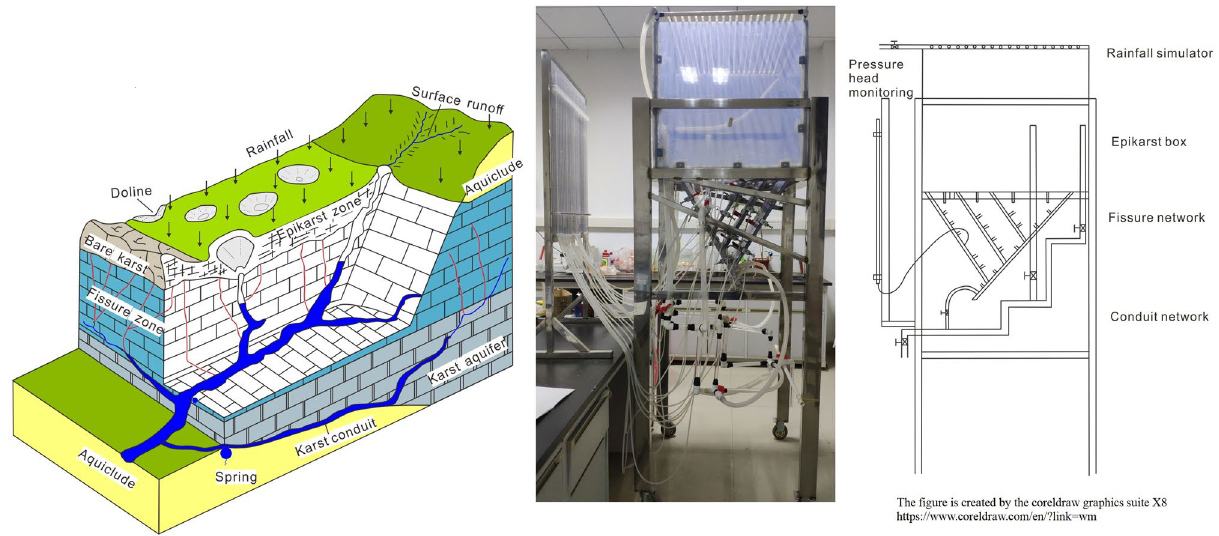
Figure 1. Conceptual model and physical model of karst fissure–conduit system 14